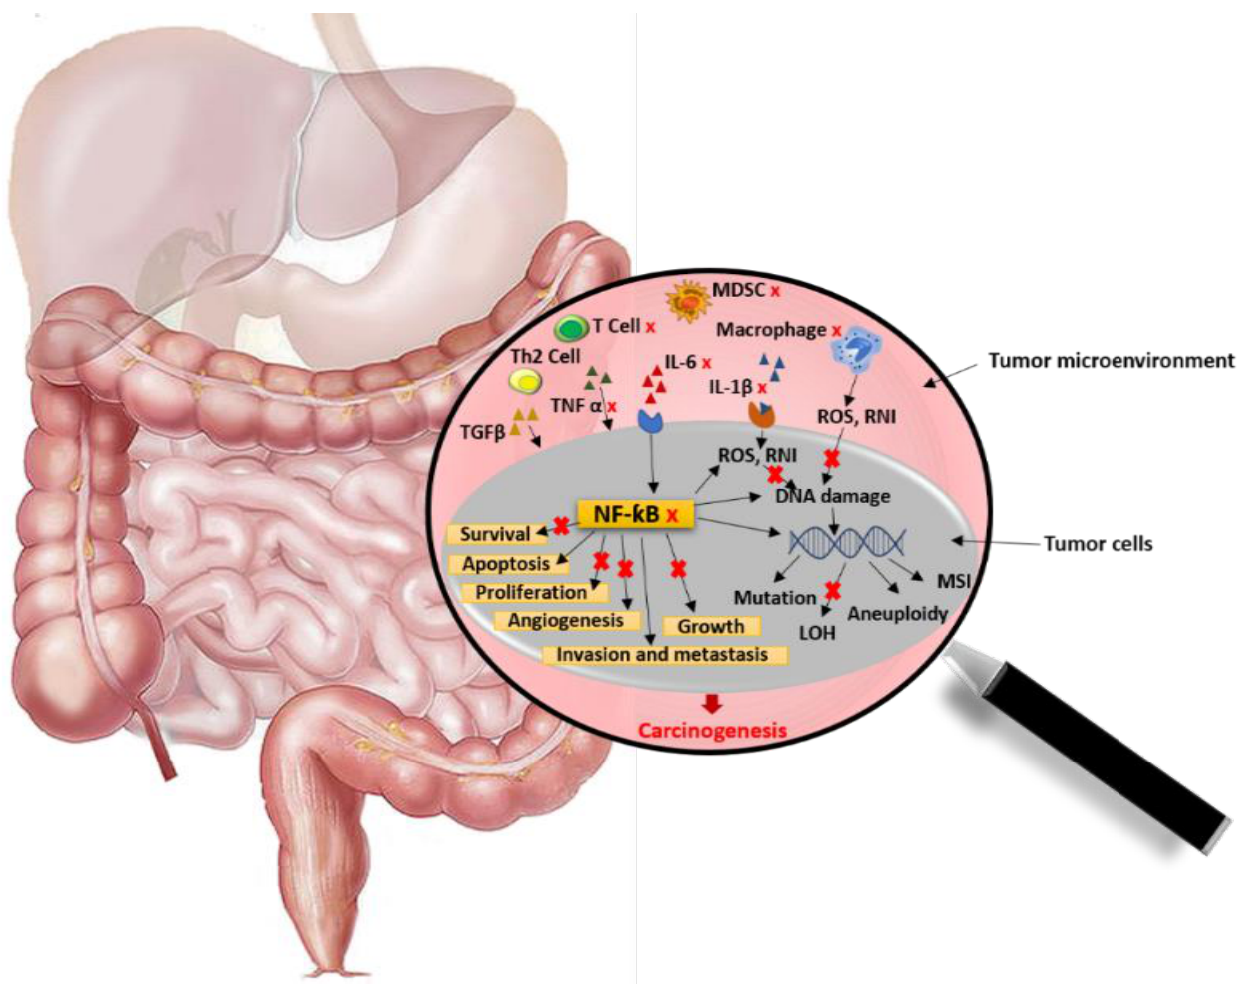
Figure 4. Mechanisms of CRC inhibition by berry polyphenols. MDSC: myeloid-derived suppressor cells; RNI: reactive nitrogen intermediates; LOH: loss of heterozygosity; MSI: microsatellite instability. Berry polyphenols target tumor cells by inhibiting NF-kB and related pathways, COX-2, iNOS, and the Bcl-2/Bax ratio. They affect the tumor microenvironment by inhibiting proinflammatory cytokine release (TNF-c, IL-1, IL-6 and IL-10, GM-CSF, and IL-8), T-cell proliferation and MDSC activity, and causing a decrease in macrophage and neutrophils infiltrated. Berry polyphenols also inhibit aneuploidy by reducing LOH and suppressing the expression of DNMT, DNMT, CDKN2A, SFRP2, SFRPS, and WIF1 in the Wnt pathway.